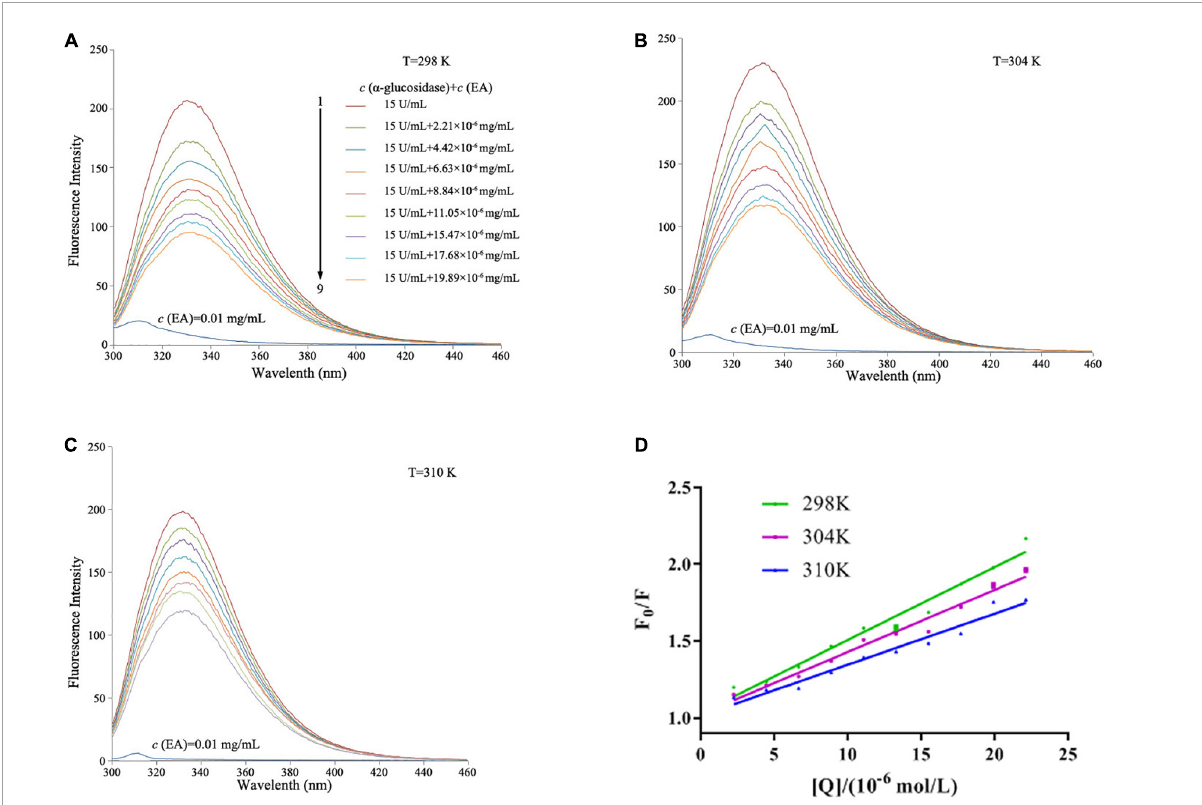
FIGURE3 The influence of EA on the fluorescence spectra of α -glucosidase at different temperatures. (A) 298 K. (B) 304 K. (C) 310 K. The concentration of α -glucosidase was 15 U/mL with or without different concentrations (2.21, 4.42, 6.63, 8.84, 11.05, 15.47, 17.68, and 19.89 × 10 − 6 mol/L) of EA for the curves 1 → 9. EA alone almost showed no fluorescence at the concentration of 0.01 mg/mL, λ = 280 nm. (D) The Stern–Volmer plots of the fluorescence quenching of α -glucosidase that interacted with EA at different temperatures.